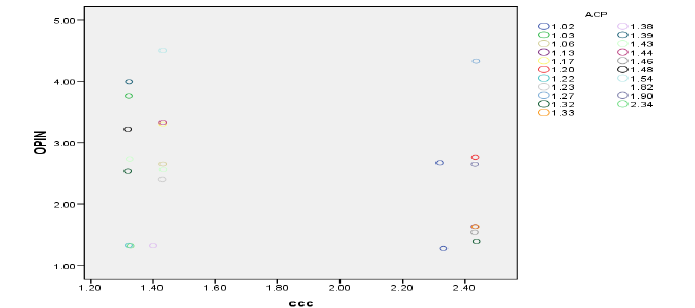
Fig. 6. Capital inflow and gaining profit